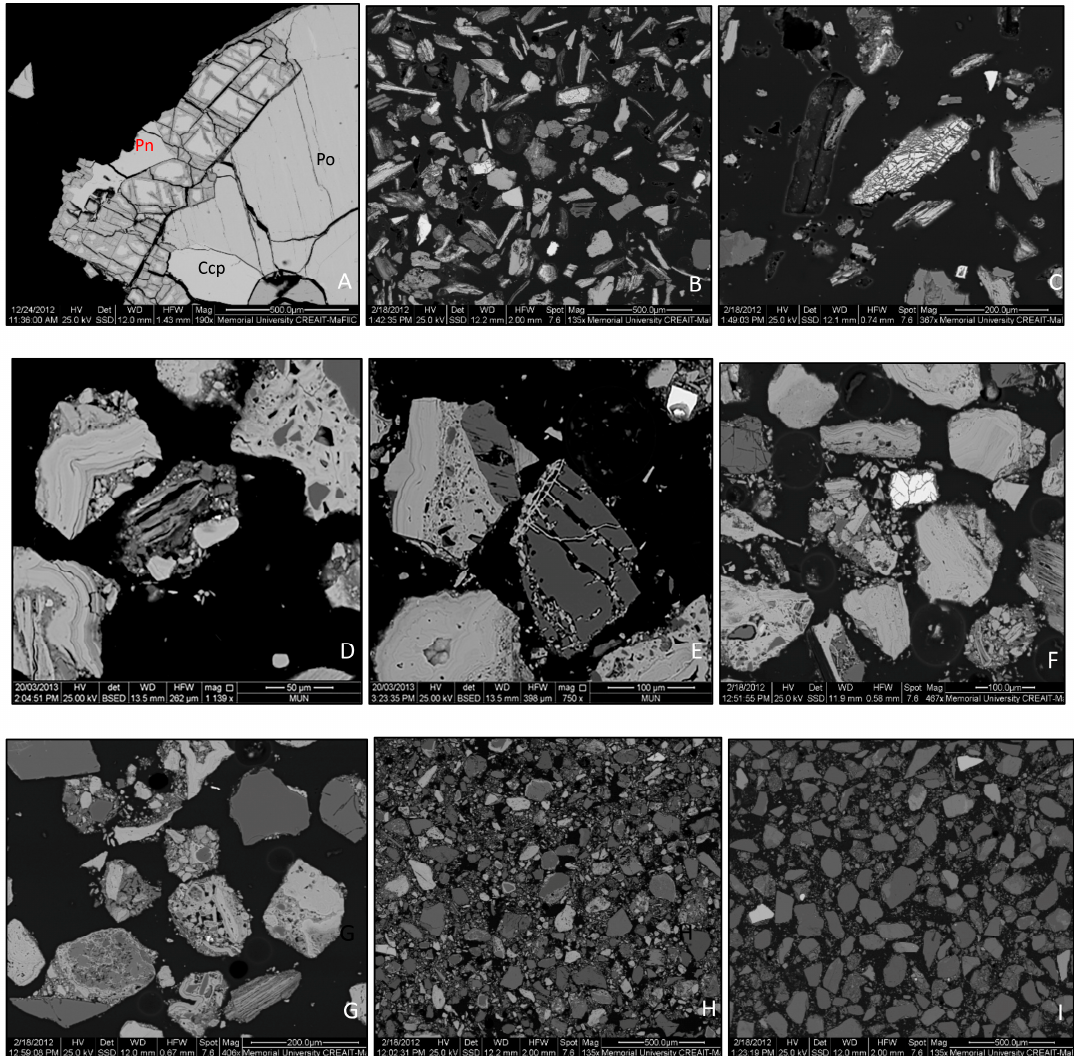
Figure 12. BSE images of polished thin section (OV-11-11) and polished grain mounts from a transect through the Voisey’s Bay Mini-Ovoid deposit: ( A ) Chalcopyrite (Ccp)-pyrrhotite (Po)-pentlandite (Pn) massive sulphide, where the Pn is oxidized along fractures and Po is twinned (sample OV-11-11), ( B ) acicular grains in sample OV-11-12, ( C ) highly oxidized, acicular Pn grain (white) in sample OV-11-12, ( D ) oxidized sulphide minerals in sample OV-11-10, ( E ) iron oxide “fingers” in plagioclase (sample OV-11-10), ( F ) remnant Pn grain with oxidation along fractures and oxidized sulphide grains (sample OV-11-08), ( G ) oxidized sulphide grains with a remnant Po grain (white) in one mass (OV-11-08), ( H ) till in sample OV-11-07, brighter grains are iron oxides, ( I ) typical till in sample